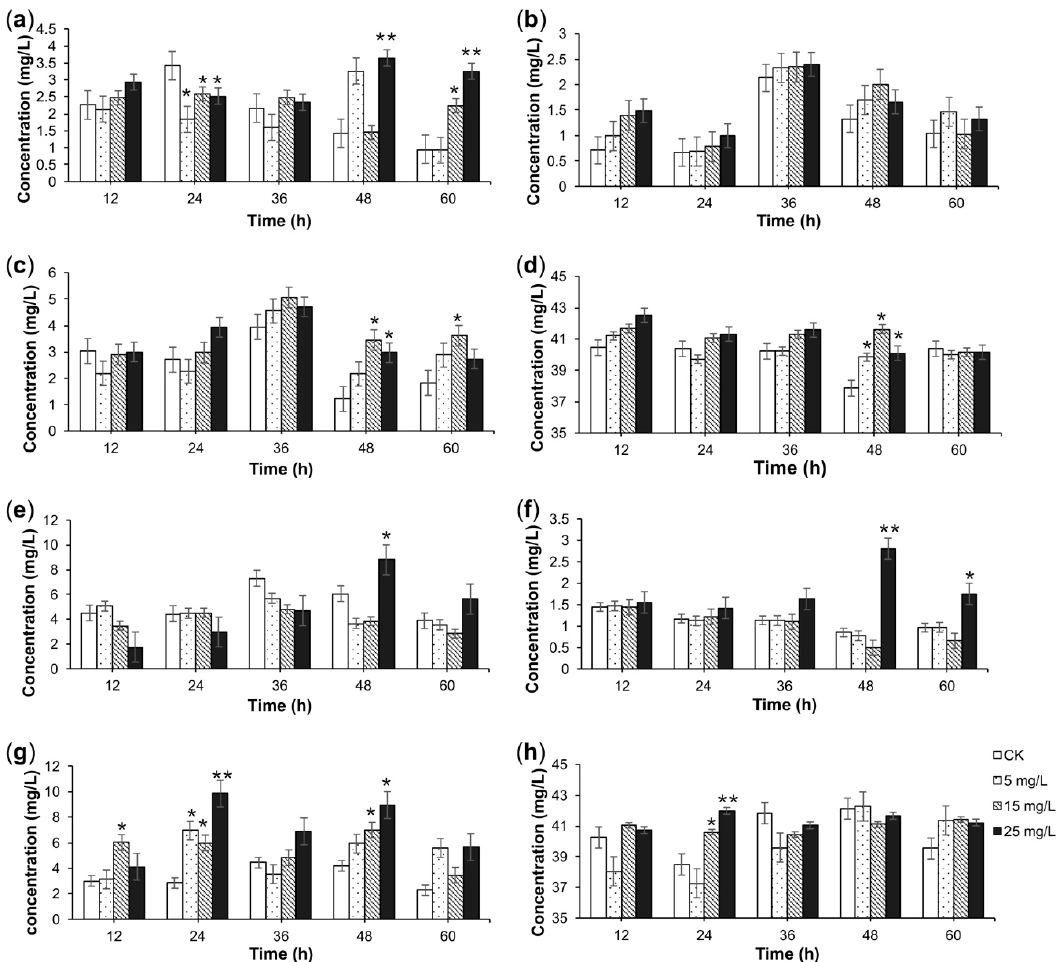
Figure 4. The effects of the A. flavus mycelium elicitor on the concentrations of TIAs. The effects of the A. flavus mycelium elicitor on the concentrations of vindoline ( a ), catharanthine ( b ), ajmaline ( c ), and total alkaloids ( d ) in four-day-old suspensions of C. roseus CMCs. The effect of the A. flavus mycelium elicitor on the concentrations of vindoline ( e ), catharanthine ( f ), ajmaline ( g ), and total alkaloids ( h ) in six-day-old suspensions of C. roseus CMCs. C. roseus CMCs treated by sterile water were labeled as the check group (CK). Data are given as the means ± SD ( n = 3). * p < 0.05, ** p < 0.01, compared with the CK group.